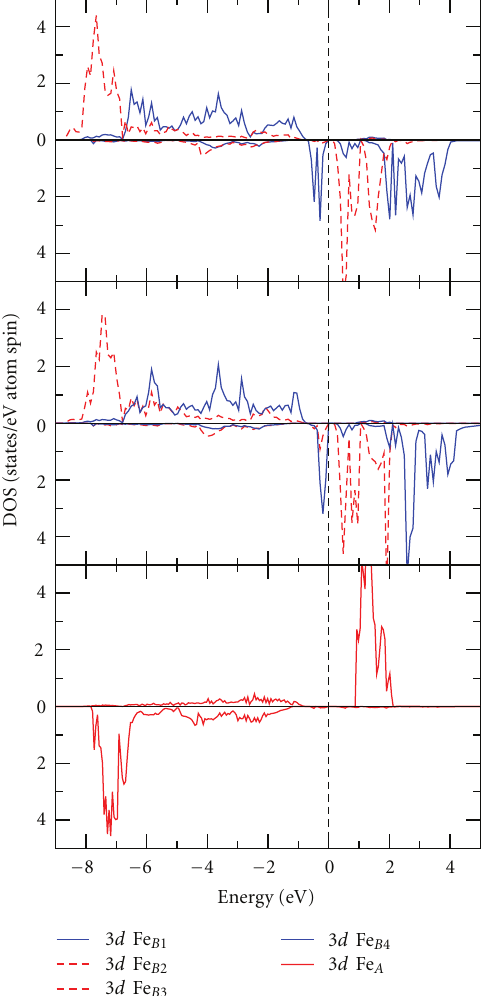
Figure 11: Partial DOS obtained from the LSDA+ U calculations with U = 5eV and J = 1eV for the P 2 /c phase of Fe 3 O 4 [155]. The Fermi level shown by dotted lines. A charge-ordered insulating solution is obtained. Fe 3 d minority states corresponding to B 1 and B 4 sites are occupied (Fe 2+ ) and located just below the Fermi level, whereas B 2 and B 3 are empty (Fe 3+ ). The charge di ff erence between 2+ and 3+ Fe B cations is found to be 0 . 23 e